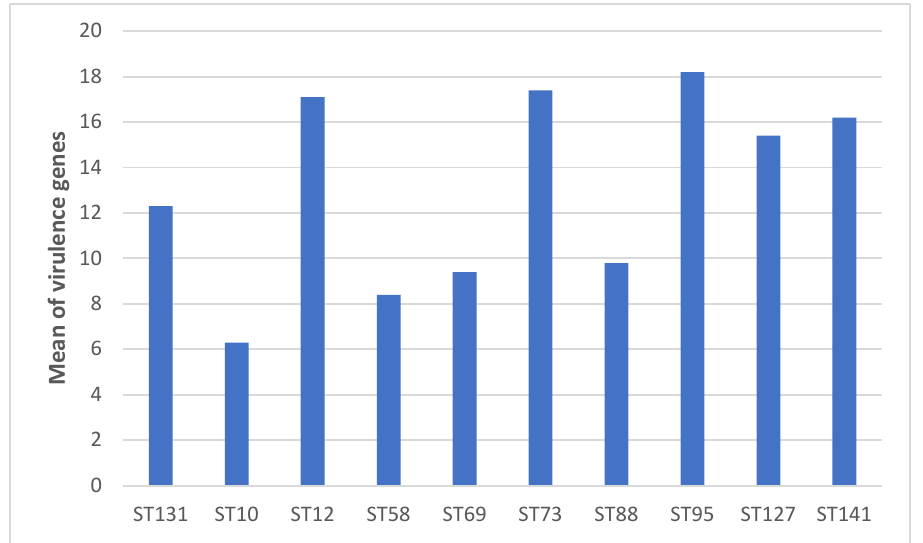
Figure 4. Mean of VF-encoding genes within dominant sequence types.